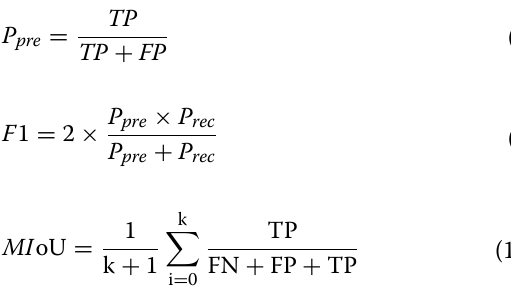
Table 3 Servers characteristics for simulated edge-cloud setup